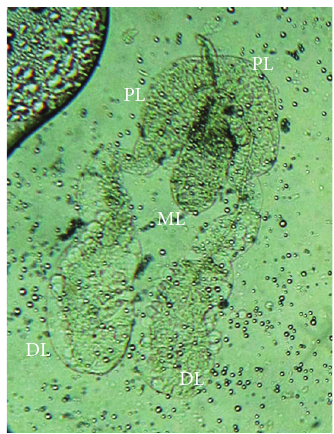
Figure 1: Adult female salivary glands of An. dirus . PL: proximal region of lateral lobe; DL: distal region of lateral lobe; ML: median